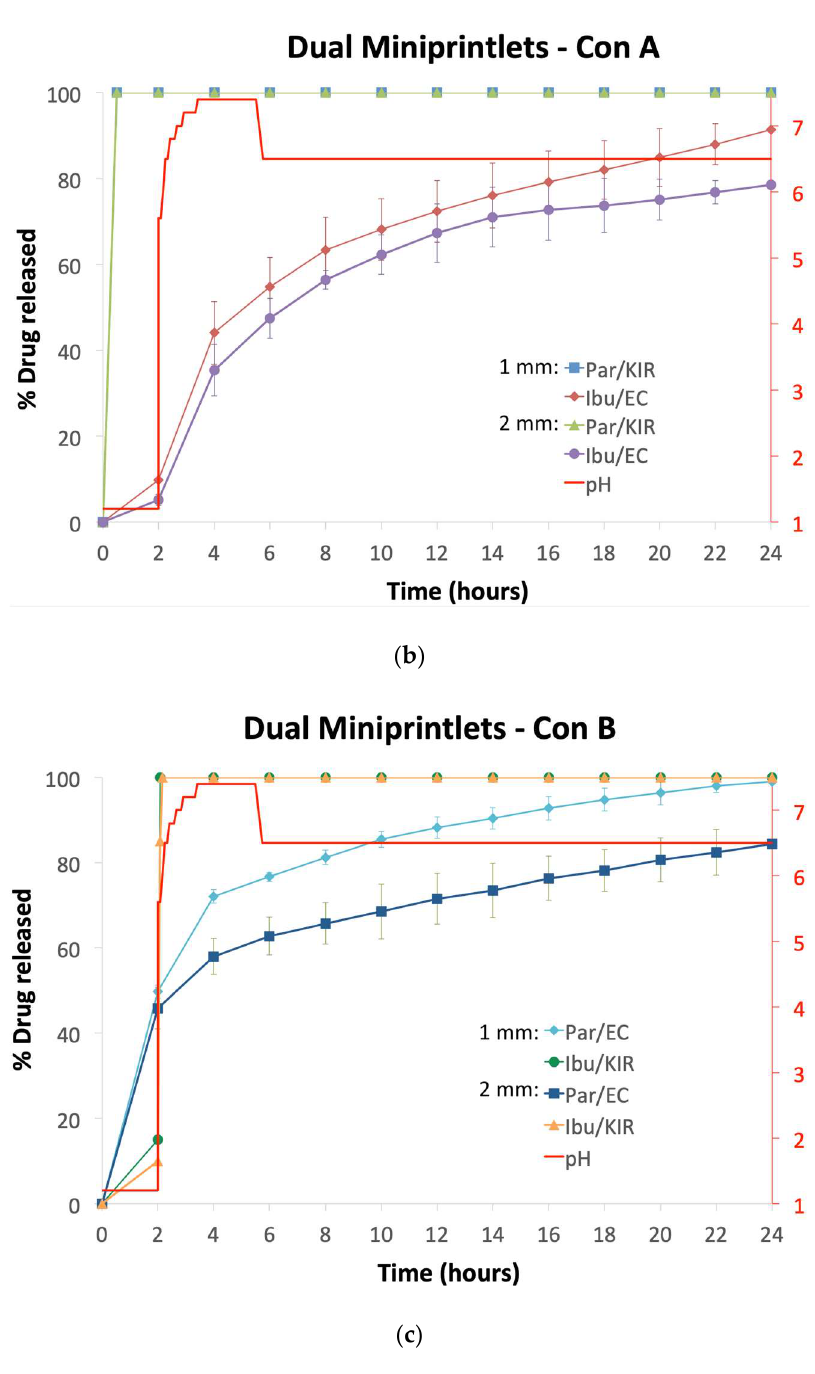
Figure 7. Drug dissolution profiles of the ( a ) single miniprintlets, and ( b ) Con A and ( c ) Con B of the dual miniprintlets. The red line shows the pH values of the media under acidic conditions for 2 h, followed by intestinal conditions using dynamic dissolution apparatus.